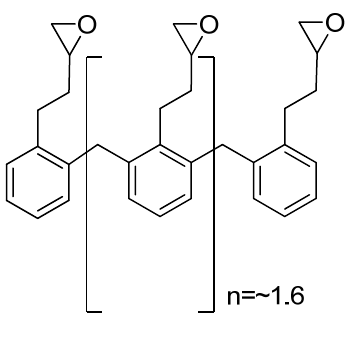
Figure 6. Chemical structure of